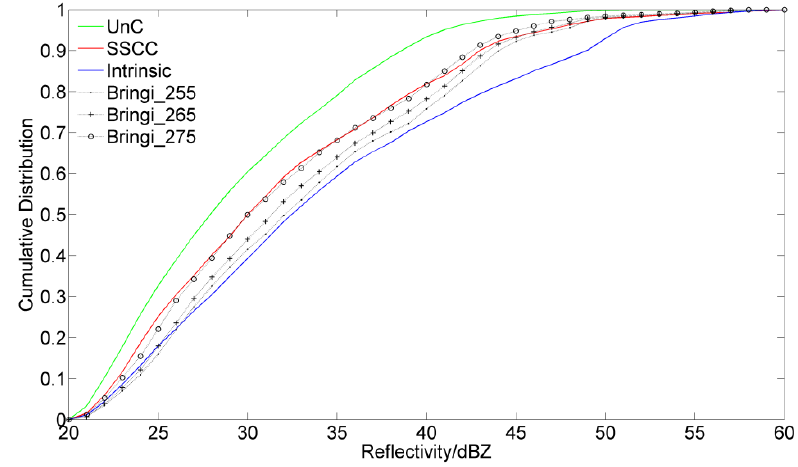
Figure 12. Cumulative distribution of reflectivity with different initial phases for convective cloud.